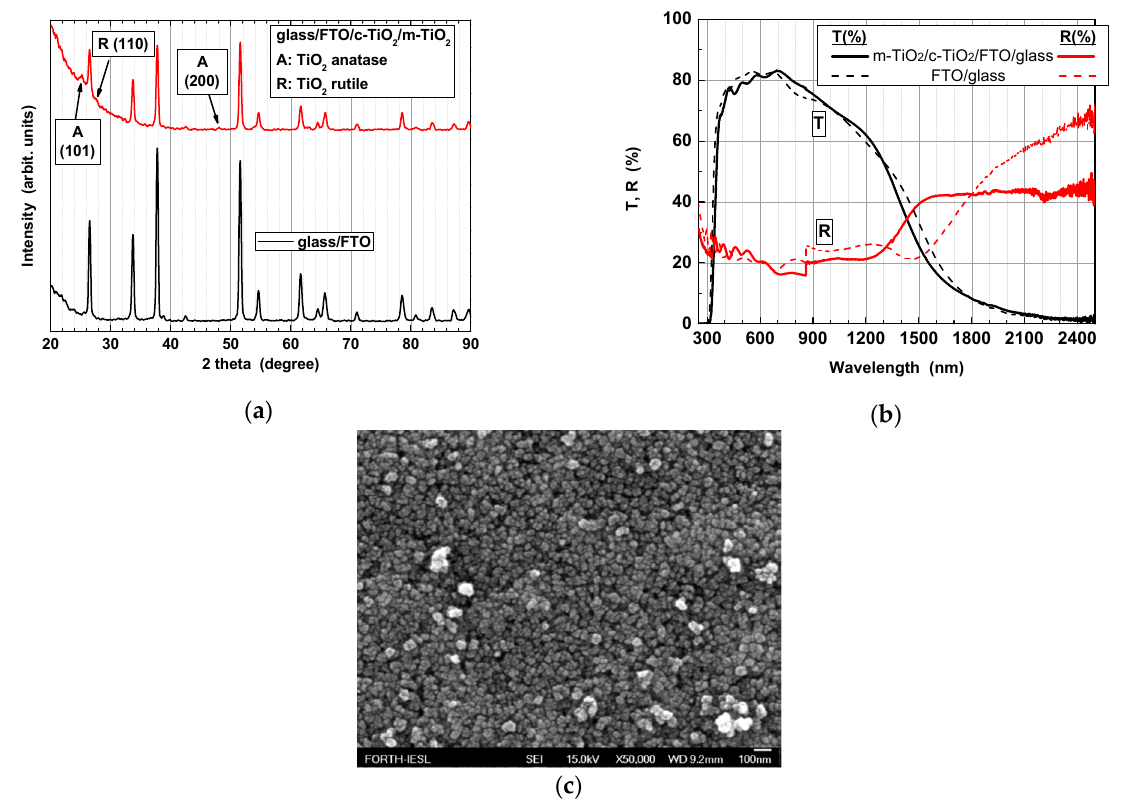
Figure 5. ( a ) XRD patterns and ( b ) UV-Vis-NIR transmittance and reflectance curves of m-TiO 2 /c-TiO 2 /FTO/glass and FTO/glass and ( c ) SEM surface image of m-TiO 2 /c-TiO 2 /FTO/glass.